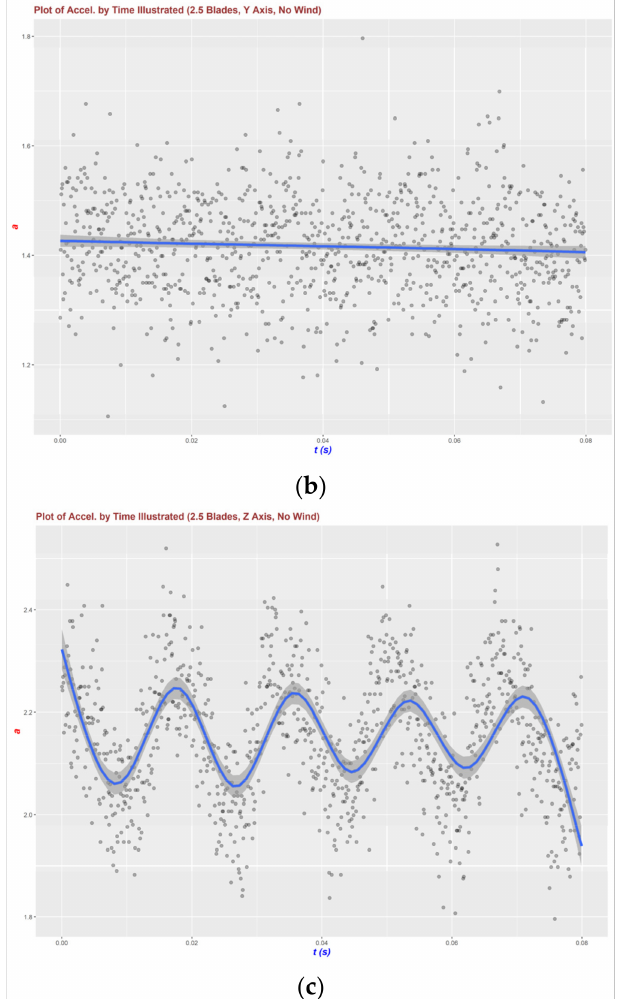
Figure 6. Magnitude and trend of acceleration for the 2.5-blade (partially broken) turbine. ( a ) Based on datasets recorded along the X axis with no wind imposed. ( b ) Based on datasets recorded along the Y axis with no wind imposed. ( c ) Based on datasets recorded along the Z axis with no wind imposed.